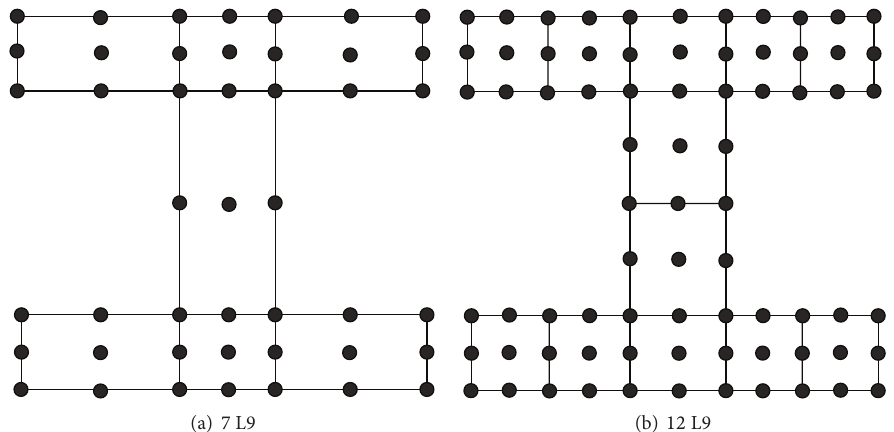
Figure 13: Distribution of L9 elements above the cross-section of the I-shaped beam.